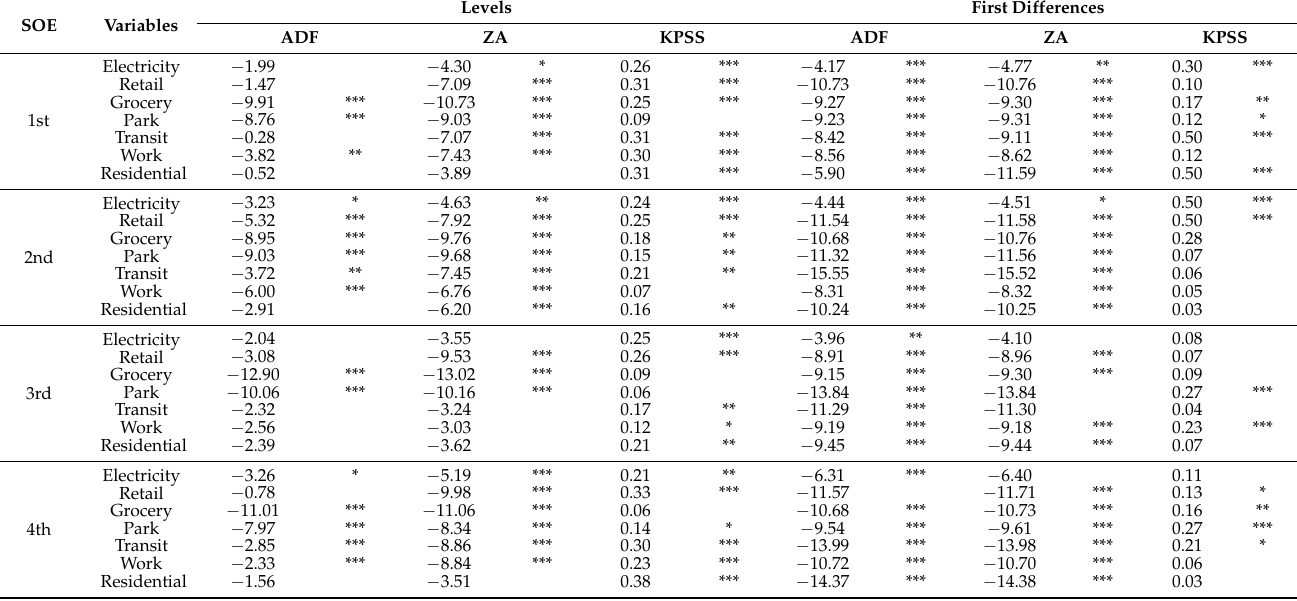
Table 5. Unit-root tests.